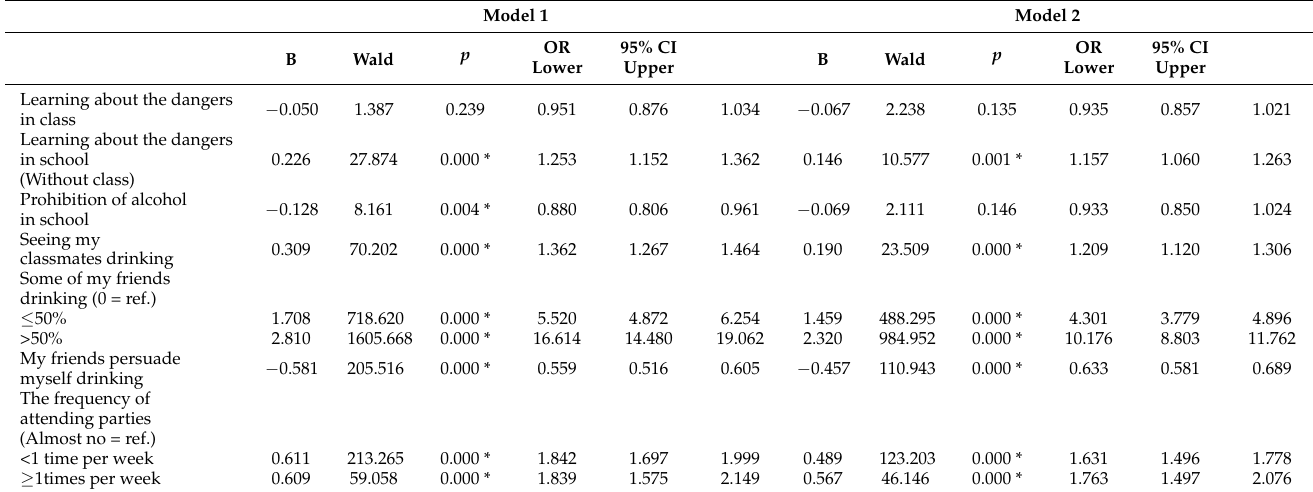
Table 4. Unadjusted and adjusted logistic regression analyses of school environment factors and getting